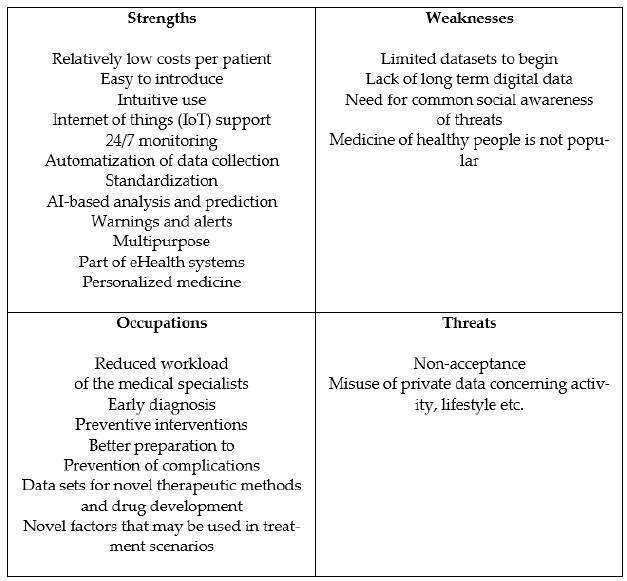
Figure 2. SWOT analysis for AI-based system of preventive medicine.